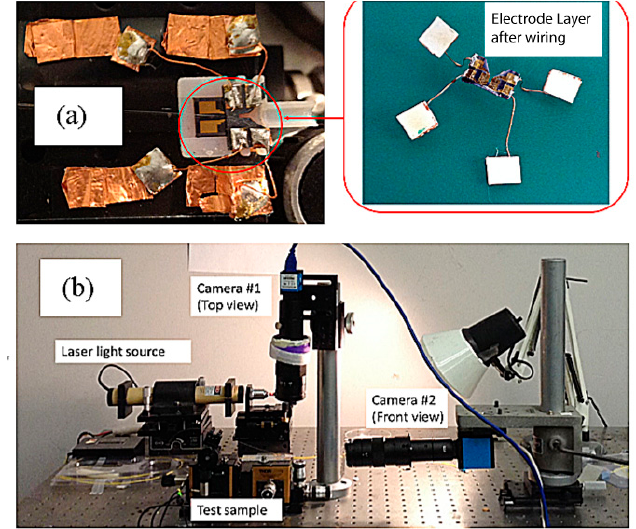
Figure 18. ( a ) MEMS device test sample: device in the red square shows the top electrode. The bottom electrode consists of the moving push-pull actuators and the cantilever waveguide (partially covered by the top electrode), ( b ) optical tests were taken by two cameras equipped with high power lenses (250× magnification).